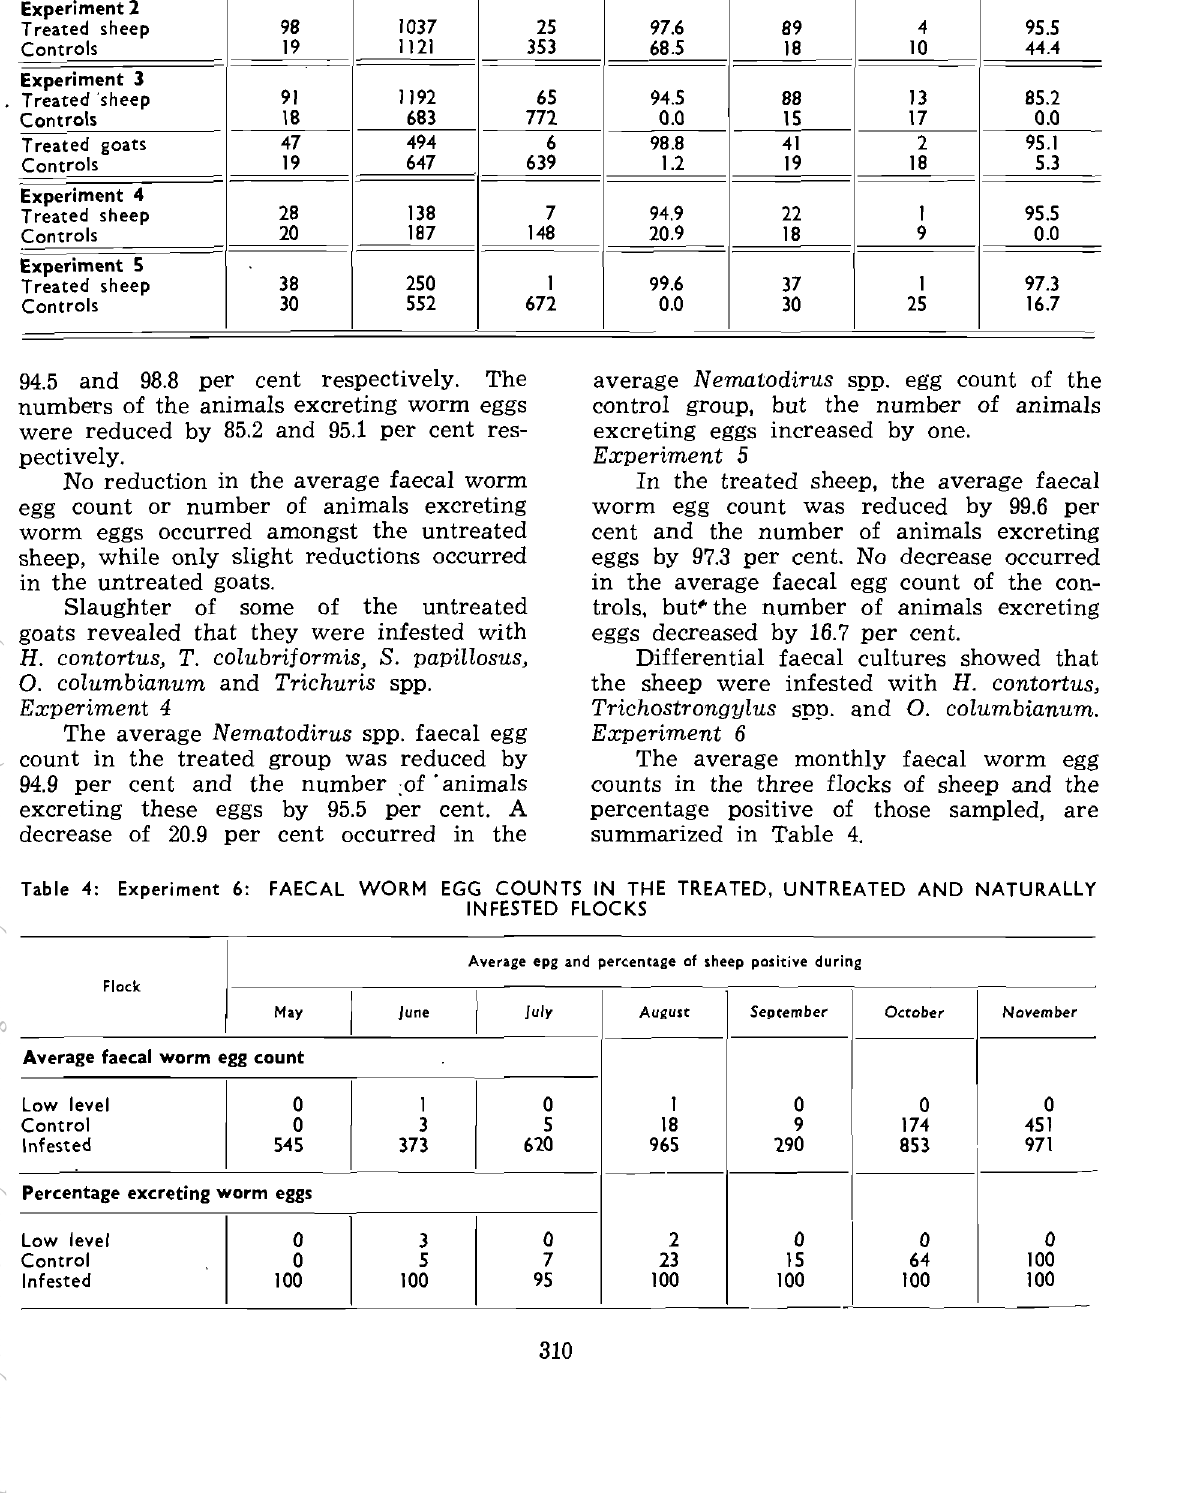
Table 3: Experiments 2 to 5: FAECAL WORM EGG COUNTS IN THE TREATED AND CONTROL GROUPS Average epg No. of Group